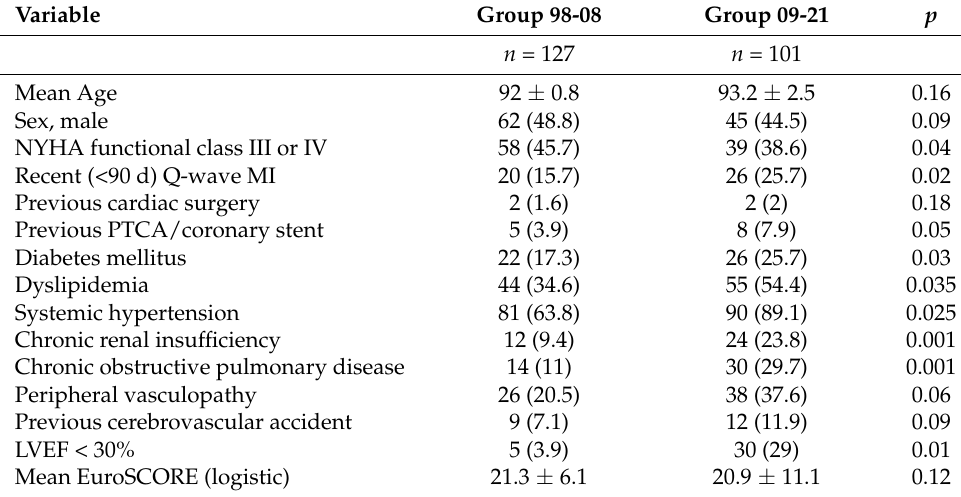
Table 1. Preoperative Characteristics.